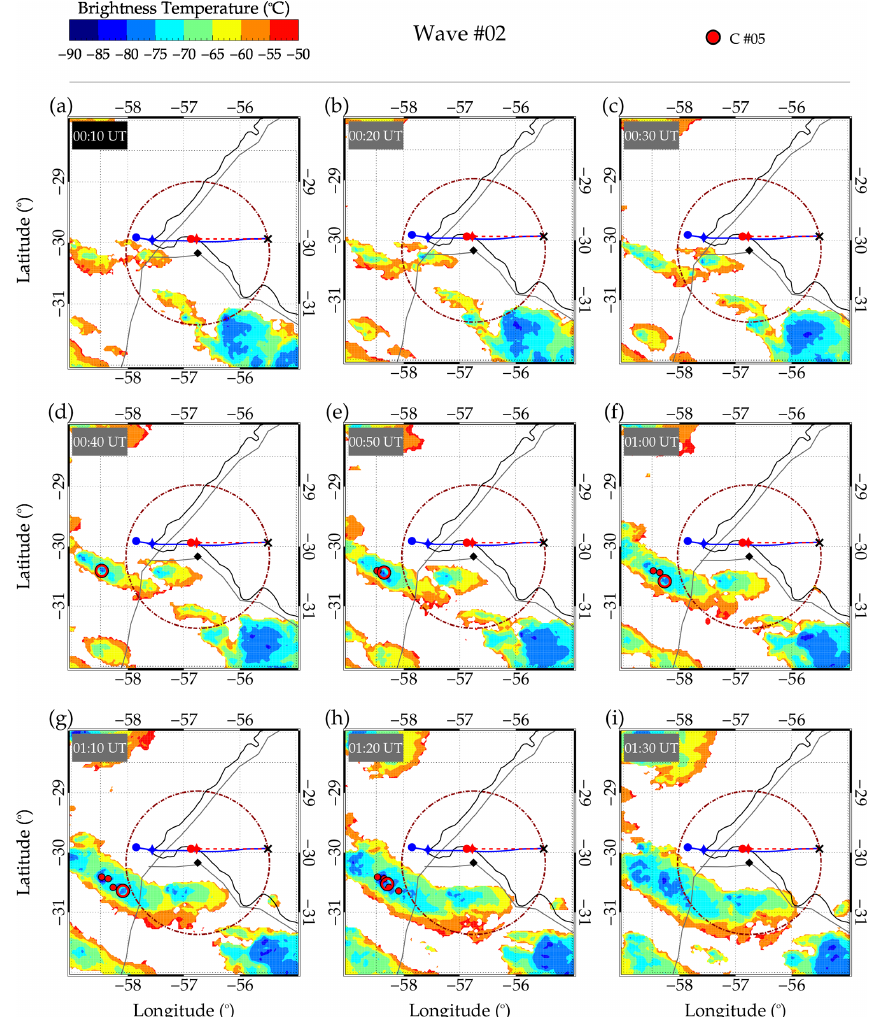
Figure 11. Tracking of the individual convective core (C), C no. 05, in space and time for Wave no.